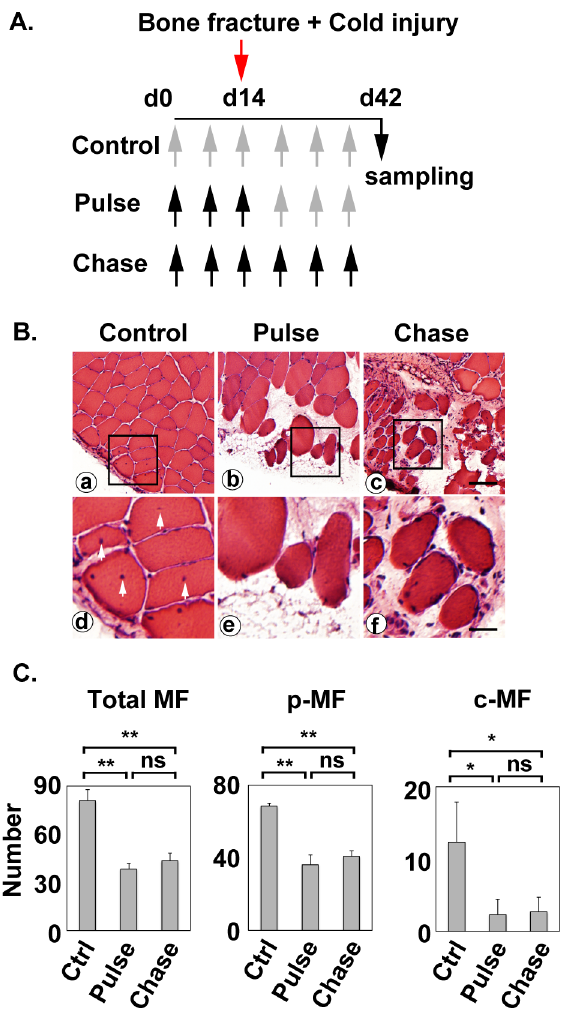
Fig 3. Combination of bone fracture and alendronate treatment causes irreversibleloss of muscle regeneration potential. (A) Experimental schedules.PBS (gray arrows) or alendronate(black arrows) was subcutaneously injectedat seven-day intervals. The femur was broken, and the vastus lateralis muscle was injuredby cold shock on day 14, and then the vastus lateralismuscle was removedon day 42. (B) Histopathology of muscle regeneration of vastus lateralis. Controlgroup (a and d), “Pulse” (b and e) and “Chase”(c and f) experimental groups are shown at low (a-c) and high (d-f) magnifications. Squares in the top panels(a-c) indicatethe areas magnifiedin the bottom panels(d-f). Arrowheads represent the centrally locatednuclei. Scale bars, 60 μ m in (a-c), 20 μ m in (d-f). (C) Numbers of peripherally nucleatedmyofibers (p- MF) and centrally nucleatedmyofibers (c-MF) were countedin the regenerating area (1.0 x 0.2 mm) of three independent samples. “Total” means the sum of both types of myofibers. The averageand standard deviation were estimated. Statistical significance(P-value)of difference betweenmuscles of control group and “Pulse” or “Chase”group, or muscles of “Pulse” group and “Chase”group was analyzedusing one-wayANOVA. ns, p > 0.05; * , p < 0.05; ** , p <